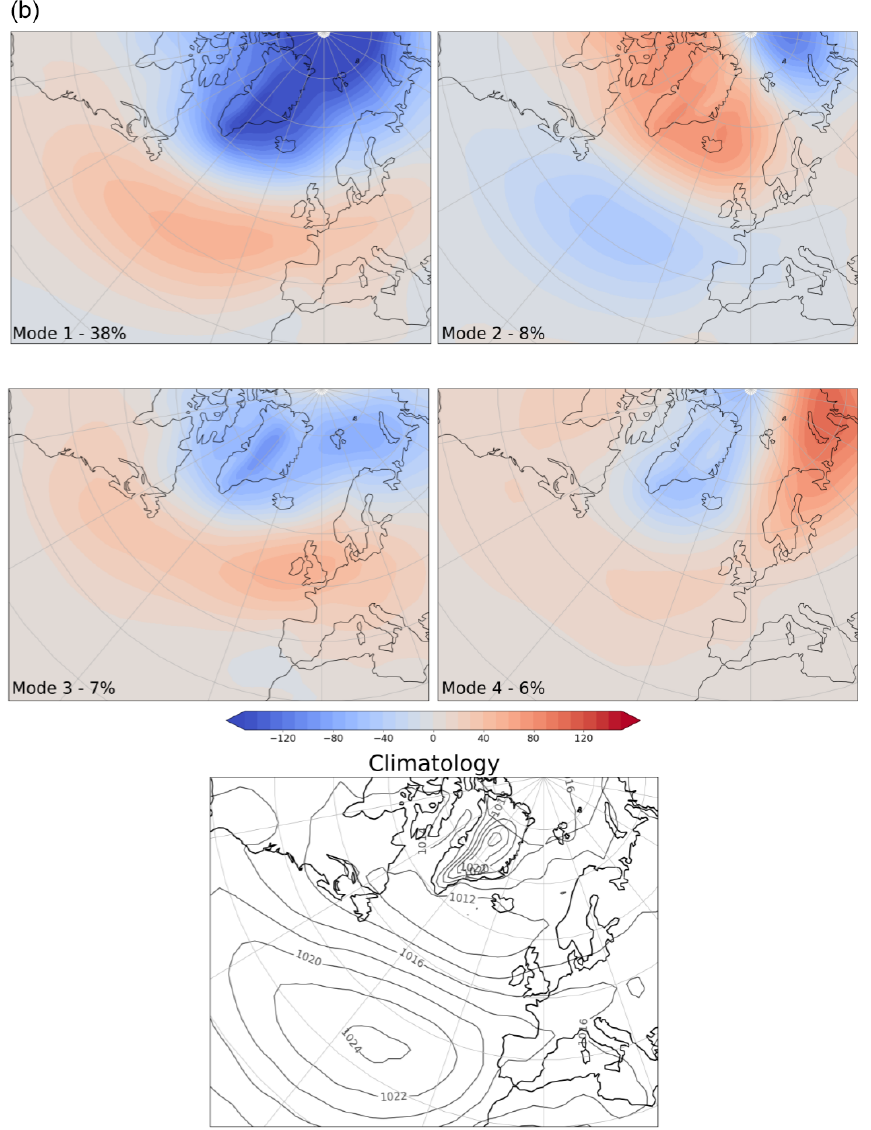
Figure A4. The SLP EOF patterns of the first four modes of atmospheric circulation for past2k run no. 1 for (a) DJF (see also van Dijk et al., 2022) and (b) the mean growing season (AMJJAS) during 1–1850CE. The SLP climatology for 1–1850CE is given in the lowest panel; contours are given in 2hPa